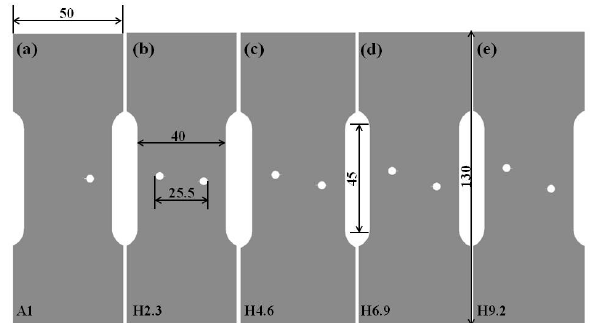
Figure 1. Sample geometry (all dimensions in mm): ( a ) specimen A1 containing a single crack; ( b ) specimen H2.3 (initial condition: crack offset H = 2.3 mm), ( c ) specimen H4.6 (initial condition: H = 4.6 mm), ( d ) specimen H6.9 (initial condition: H = 6.9 mm), ( e ) specimen H9.2 (initial condition: H = 9.2 mm). The thickness of all specimens is 2 mm.